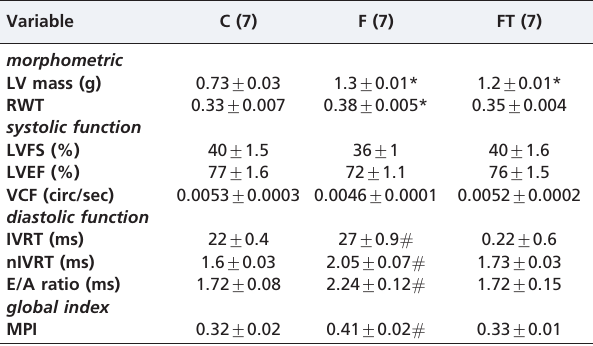
Table 1 - Cardiac morphometric and functional evaluations by echocardiography in control (C), fructose- fed (F) and trained fructose-fed (FT)